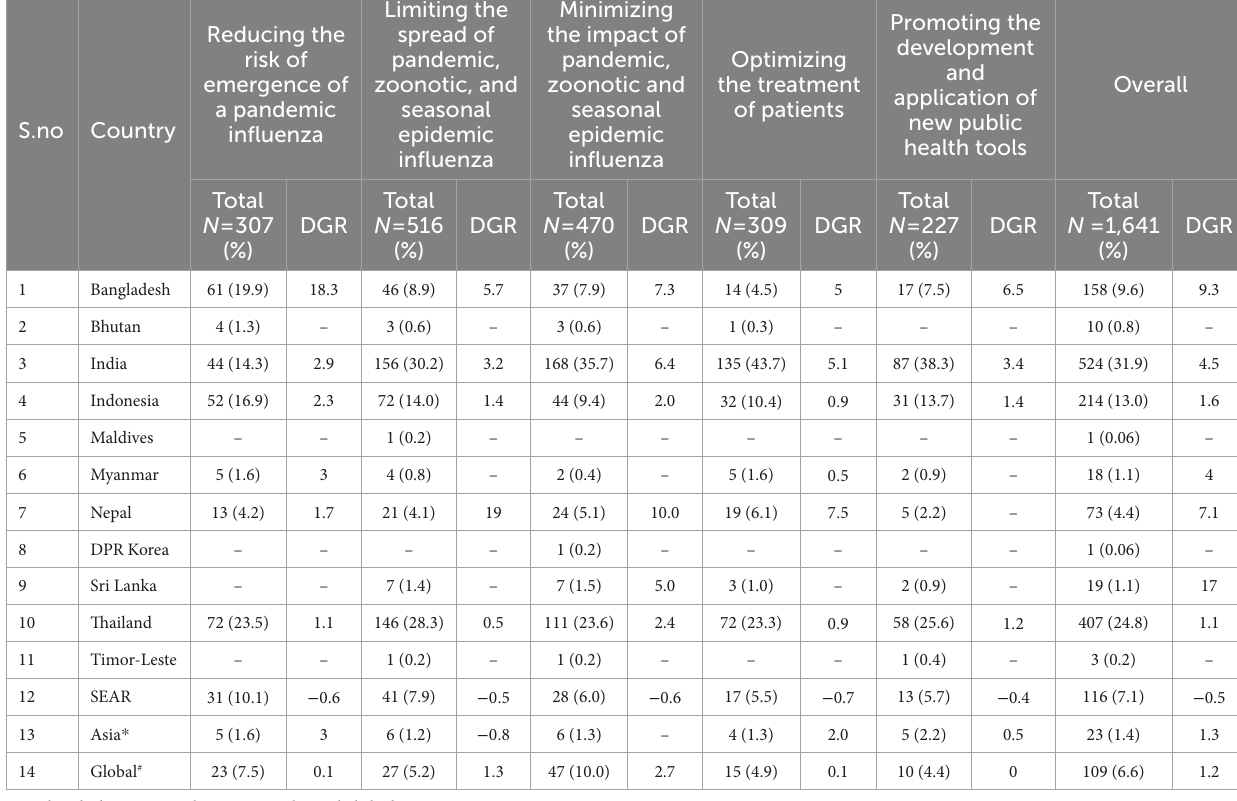
TABLE 2 Distribution of articles included in the review according to both stream and South East Asian Region countries.